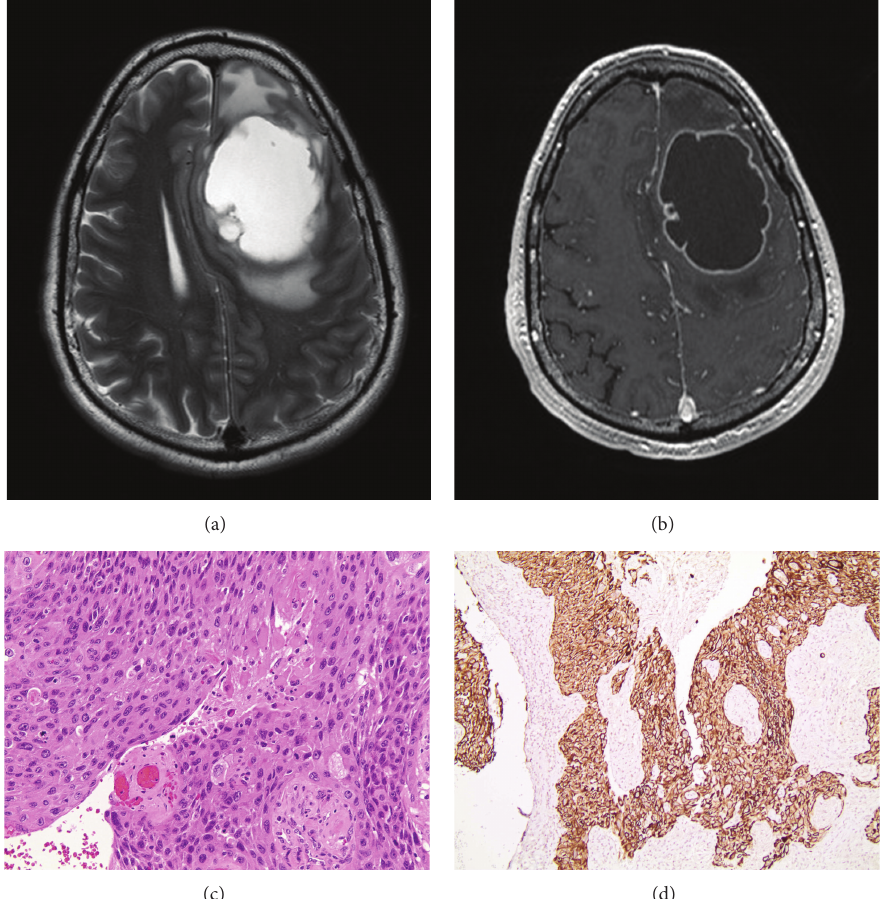
Figure 2: Radiologic and histologic features of brain metastasis. (a) Axial T2 weighted sequence demonstrates a large cystic mass in the left frontal lobe with surrounding edema, mass effect, and midline shift. (b) Axial postcontrasted T1 weighted sequence demonstrates an irregular cystic ring enhancing lesion with surrounding edema and mass effect. (c) Light microscopic examination shows squamous cell carcinoma (d) that is diffusely immunoreactive with keratin CK5/6.